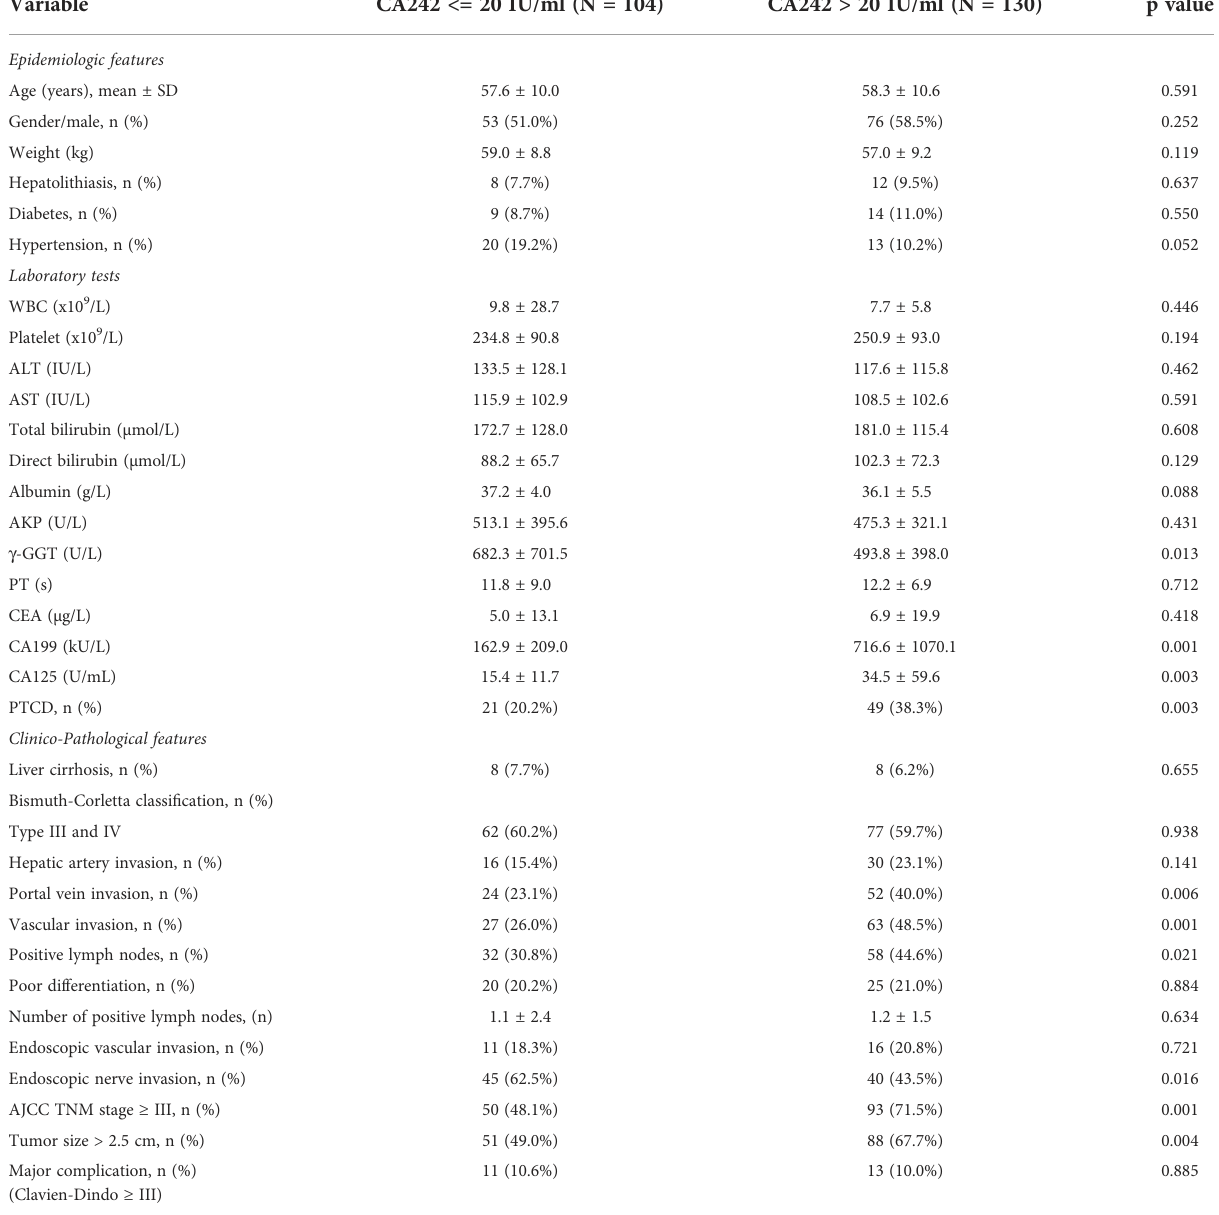
TABLE 1 Baseline characteristics between two groups strati fi ed by CA242 level.